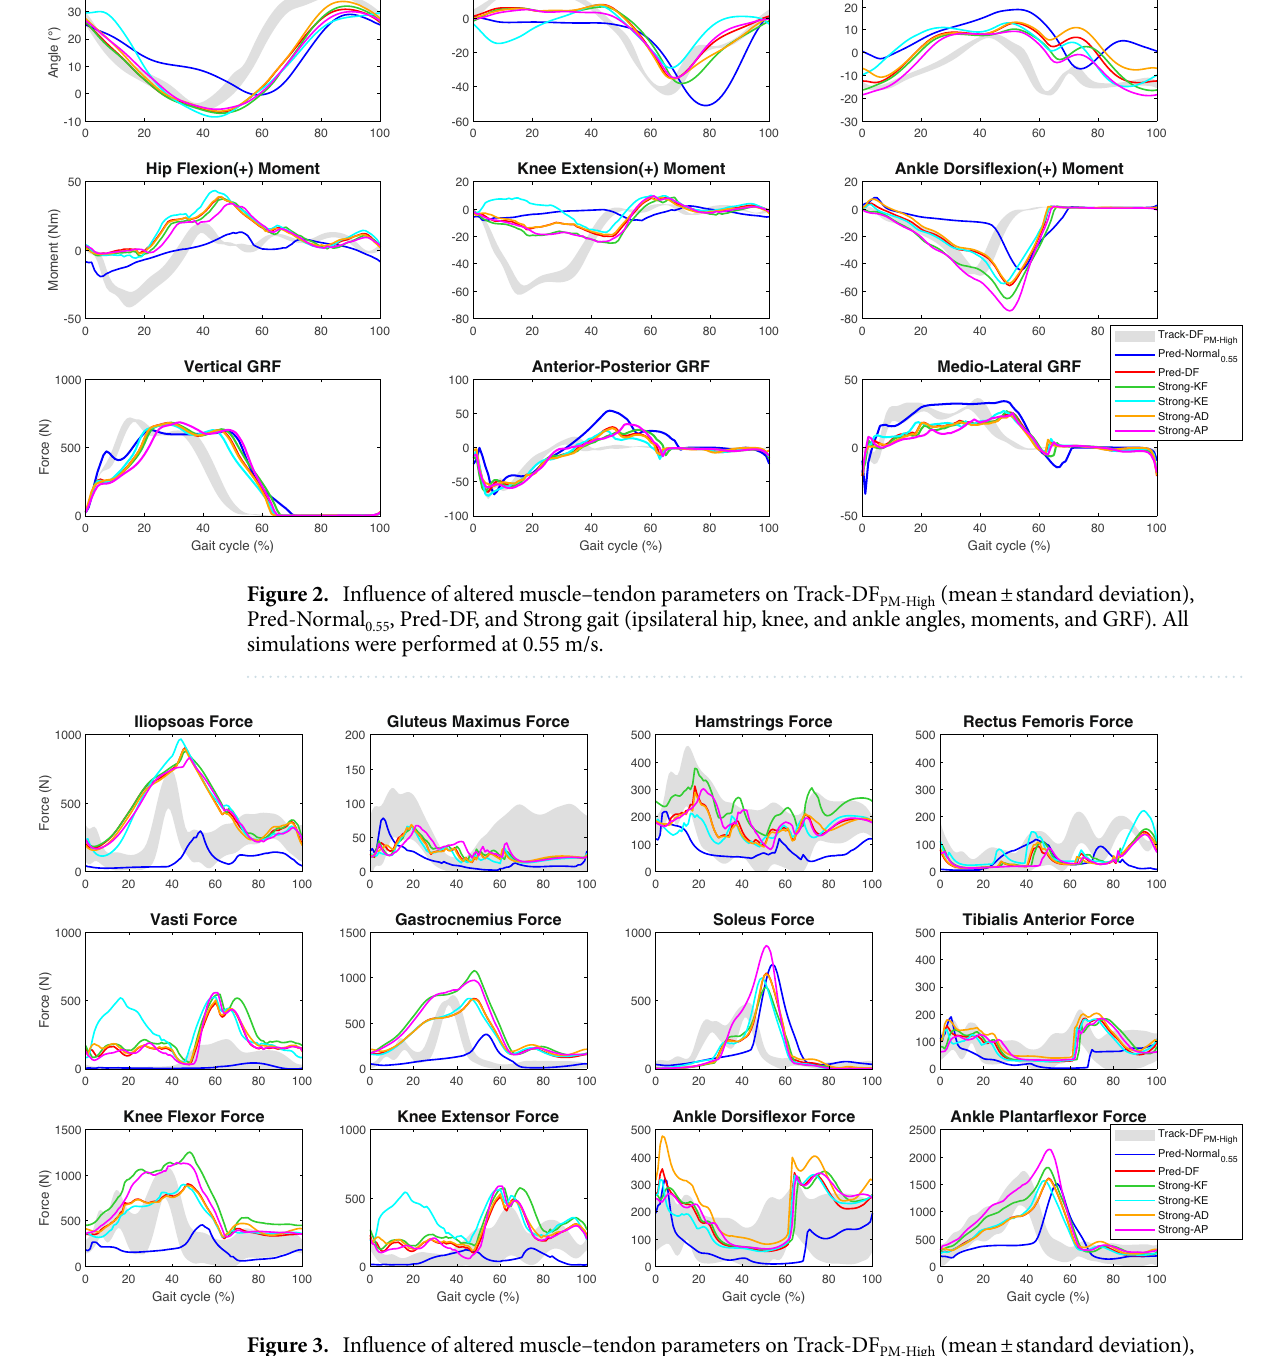
Figure 3. Influence of altered muscle–tendon parameters on Track-DF PM-High (mean ± standard deviation), Pred-Normal 0.55 , Pred-DF, and Strong gait (ipsilateral major muscle forces). All simulations were performed at 0.55